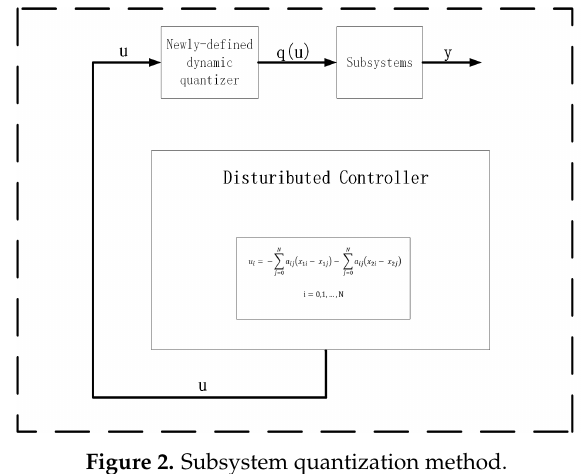
Figure 2. Subsystem quantization